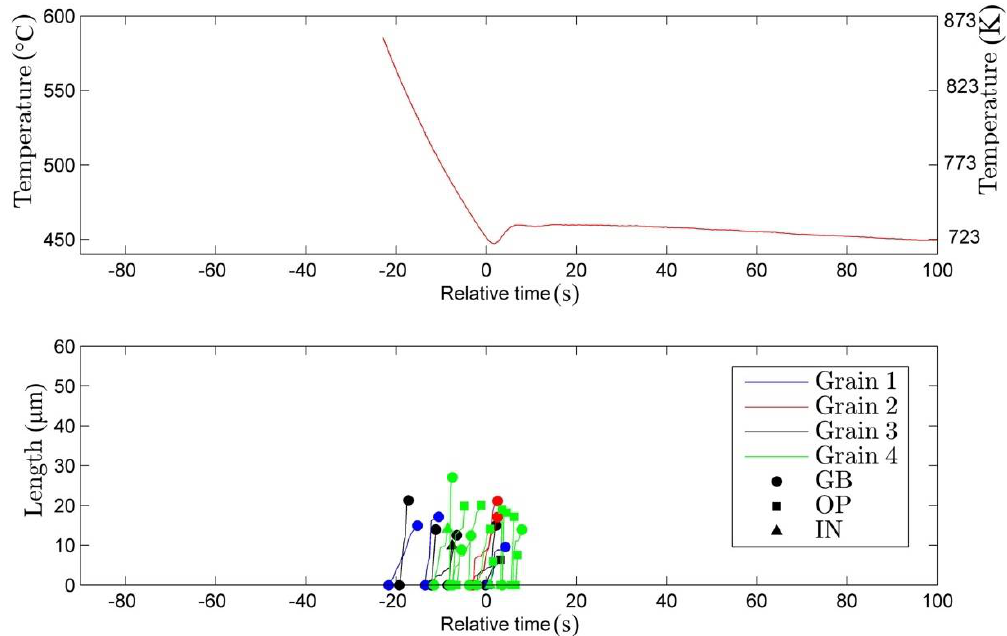
Figure 8. Temperature versus time and temporal plate growth sequence of bainitic ferrite plates in Fe-0.2C-1.5Mn-2.0Cr during isothermal holding treatment at 723 K (450 °C).